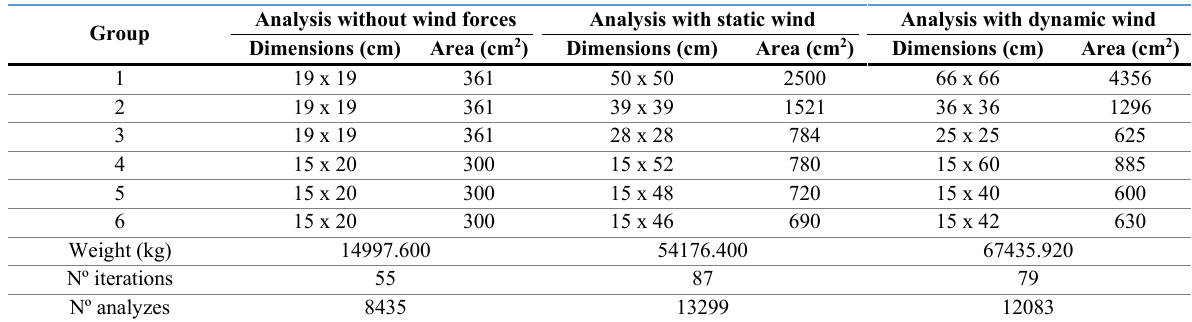
Table 7. Cross sections and structure